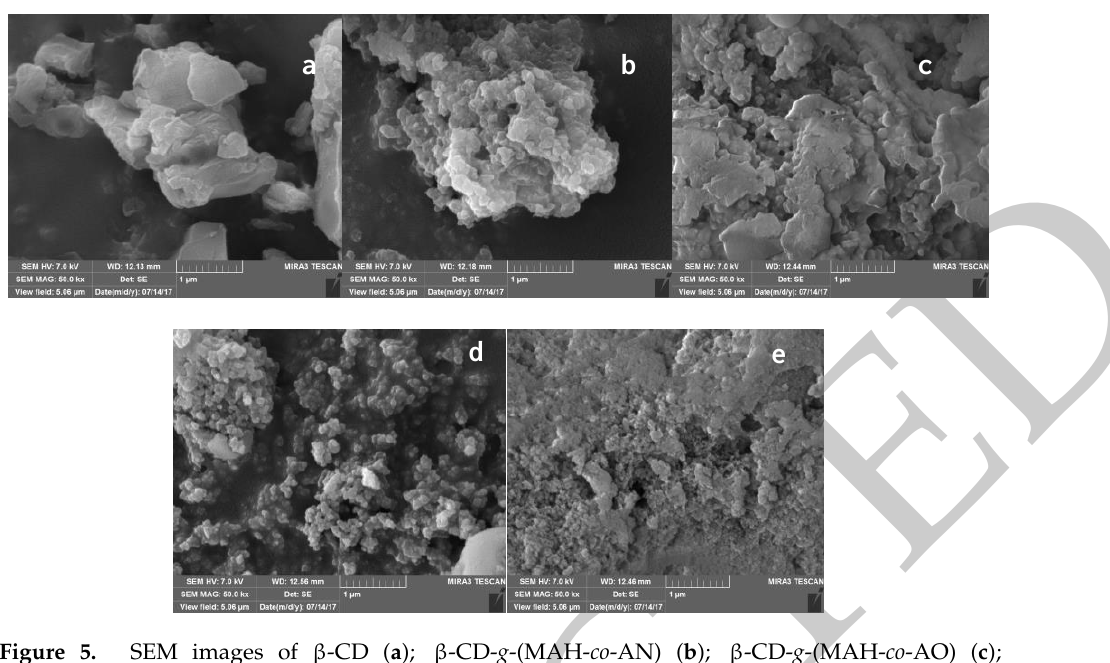
Figure 5. SEM images of β -CD ( a ); β -CD- g -(MAH- co -AN) ( b ); β -CD- g -(MAH- co -AO) ( c ); β -CD- g -(MAH- co -AO) adsorption of U(VI) ( d ); β -CD- g -(MAH- co -AO) desorption of U(VI) ( e ).